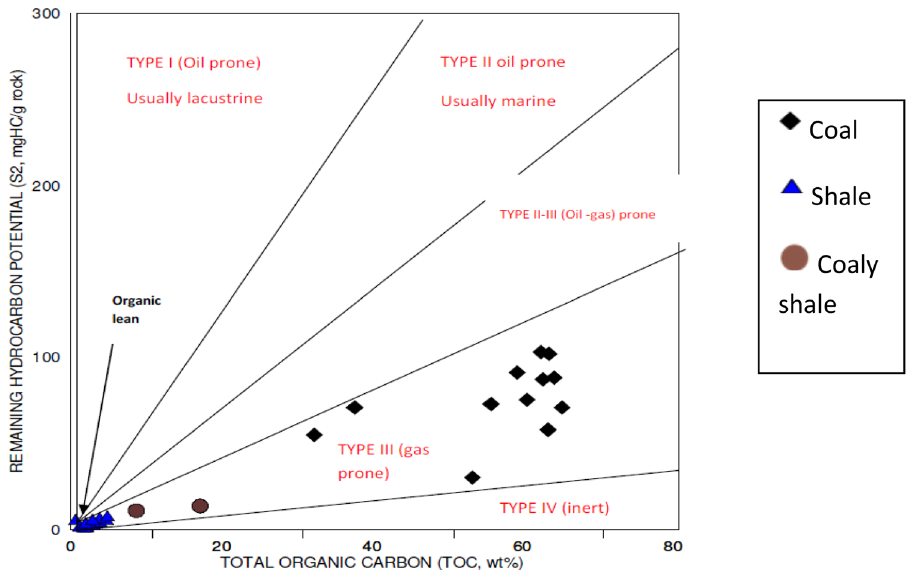
Fig. 7 S 2 versus TOC plots for coal and shale samples of Maiganga coal mine, Gongola Basin. The plot indicates type III kerogen (gas prone) for the samples. The shale samples are organically lean. After Langford and Blanc-Valleron (1990)